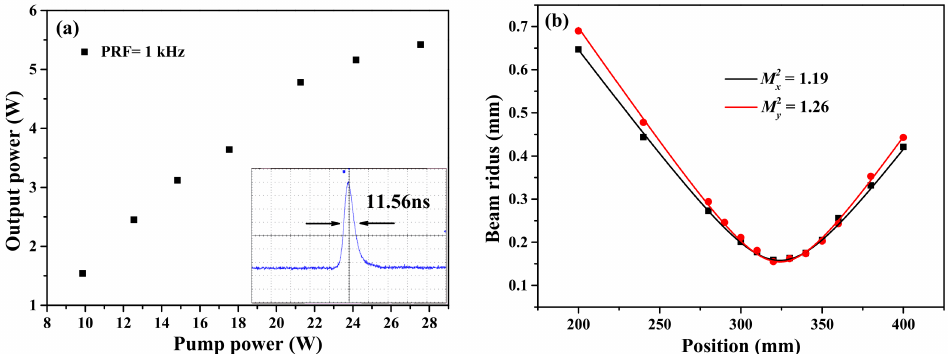
Figure 3. ( a ) Output power and pulse width, and ( b ) beam quality factor of Ho:YAG